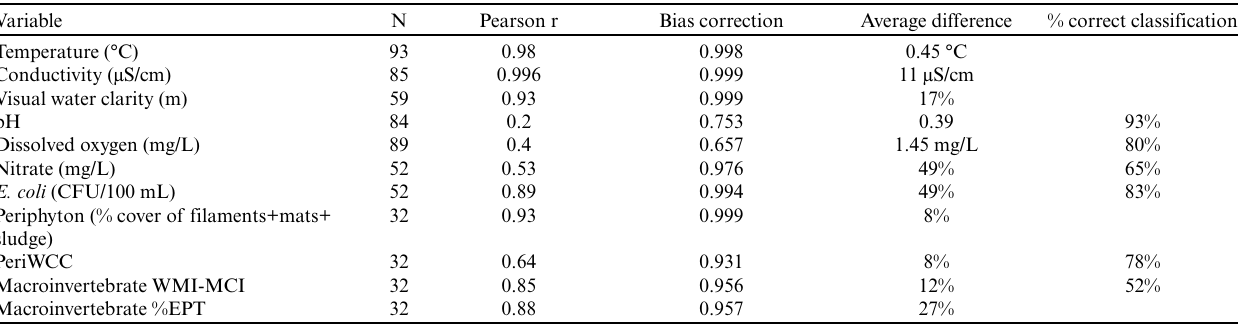
Table 2 . Correlations (as Pearson r correlation coefficients) between community group and council measurements for water quality and biological variables. Bias correction factor measures how far the best-fit line deviates from the 1-to-1 line (a factor of 1 means no deviation). Average difference (between community group and council measurements) is expressed as absolute values if constant over the range, or as a % if the difference increases at higher values. % correct classification is based on four classes defined by National Objectives Framework attribute